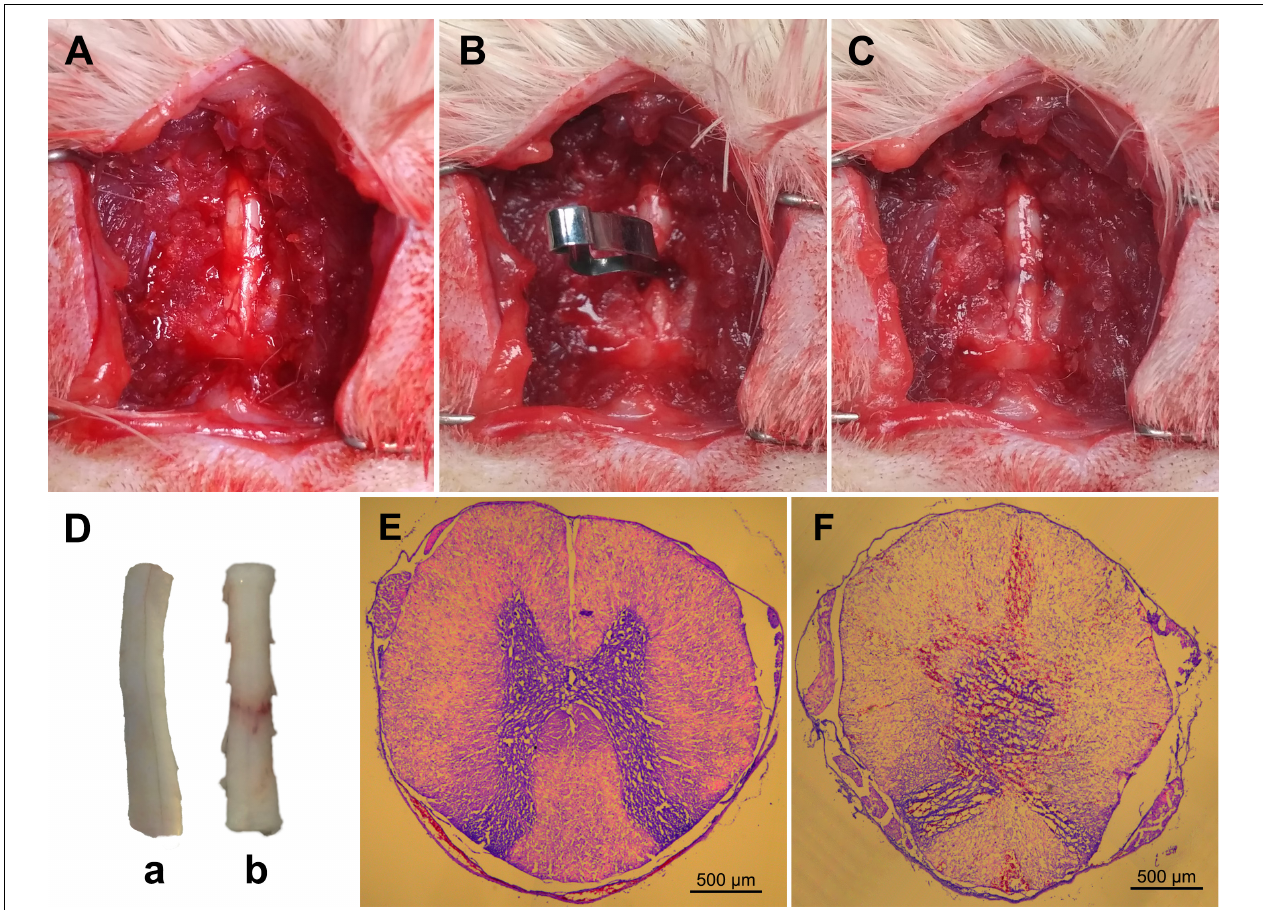
FIGURE 2 | Representative figures showing the surgical procedures used to establish the clip compressive model of t-SCI: the exposed rat spinal cord (A) ; compression of the exposed spinal cord with a vascular clip (B) ; crushed site (C) . Representative spinal cord samples showing normal spinal cord ( D , a) and crushed injury of spinal cord by vascular clip ( D , b). Typical axial spinal cord sections from the spinal cord: normal spinal cord structure in the sham group (E) ; spinal cord swelling, disorganization, and bleeding in the t-SCI 24 h group (F) .